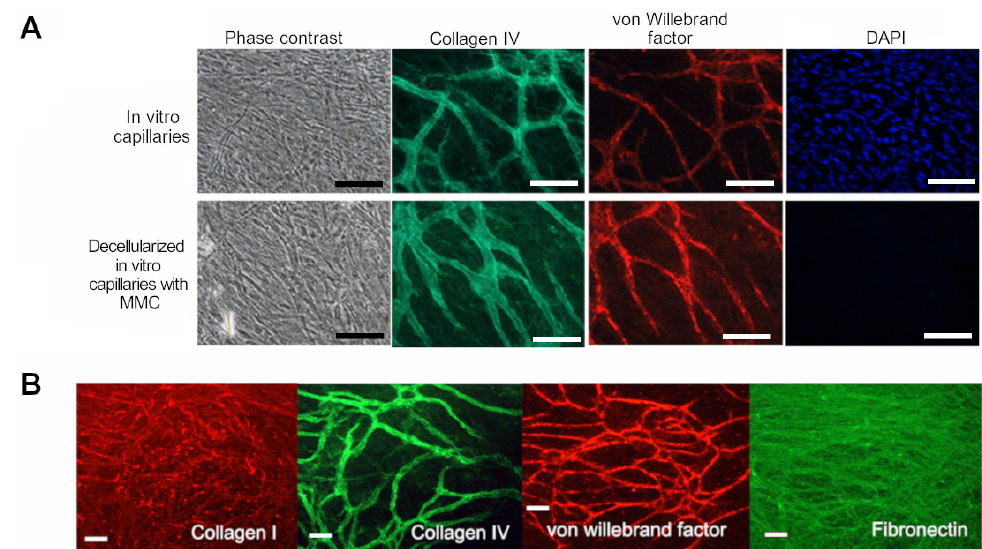
Figure 1. Immunofluorescence images of the proteins in Ficoll-Paque Plus crowded and decellular- ized in vitro capillaries. ( A ) Comparison of the in vitro capillaries without macromolecular crowder (MMC) or decellularization (top row) and Ficoll-Paque Plus crowded and decellularized in vitro capillaries (bottom row). The morphology of the culture imaged with phase contrast and expression of basement membrane marker Collagen IV-FITC (green), endothelial cell marker von Willebrand factor-A568 (red), and nucleus/DNA stain DAPI (blue). The capillaries with MMC have a thicker layer of Collagen IV, also these decellularized capillaries lack DNA seen as negative DAPI staining. ( B ) The staining of decellularized in vitro capillaries with MMC shows the presence of common ECM proteins fibronectin (green) and Collagen I (red), deposited by the hASC and HUVEC in the presence of macromolecular crowding. The endothelial cell marker von Willebrand factor-A568 (red) and basement membrane marker Collagen IV-FITC (green) are showing the localization of the decellularized in vitro capillaries. Decellularization has not removed these proteins. Immunostainings are performed with anti-von Willebrand factor visualized with A568 (red), anti-fibronectin (FITC, green), anti-Collagen I (A568, red), and Collagen IV (FITC, green). Scale bars 100 µ m. Imaged with Nikon Eclipse Ti-s inverted fluorescence